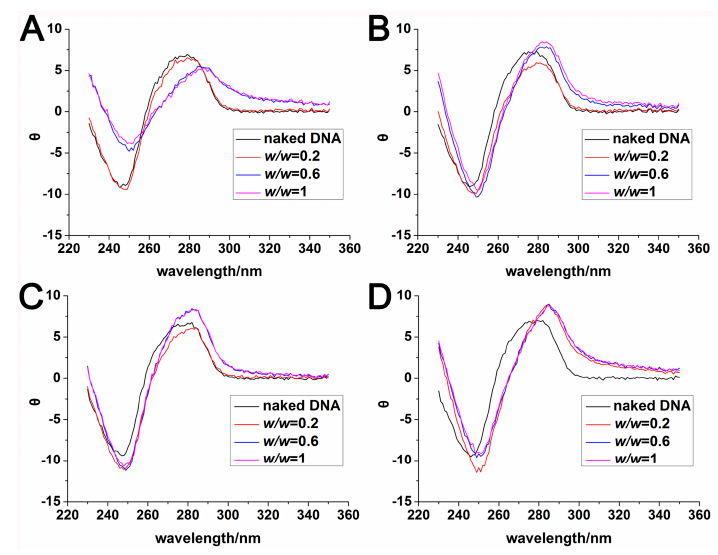
Figure 2. CD spectra of DNA/polycations (( A ) OEI-W10 ; ( B ) OEI-F10 ; ( C ) OEI-L10 ; ( D ) OEI ) with different w/w ratios.